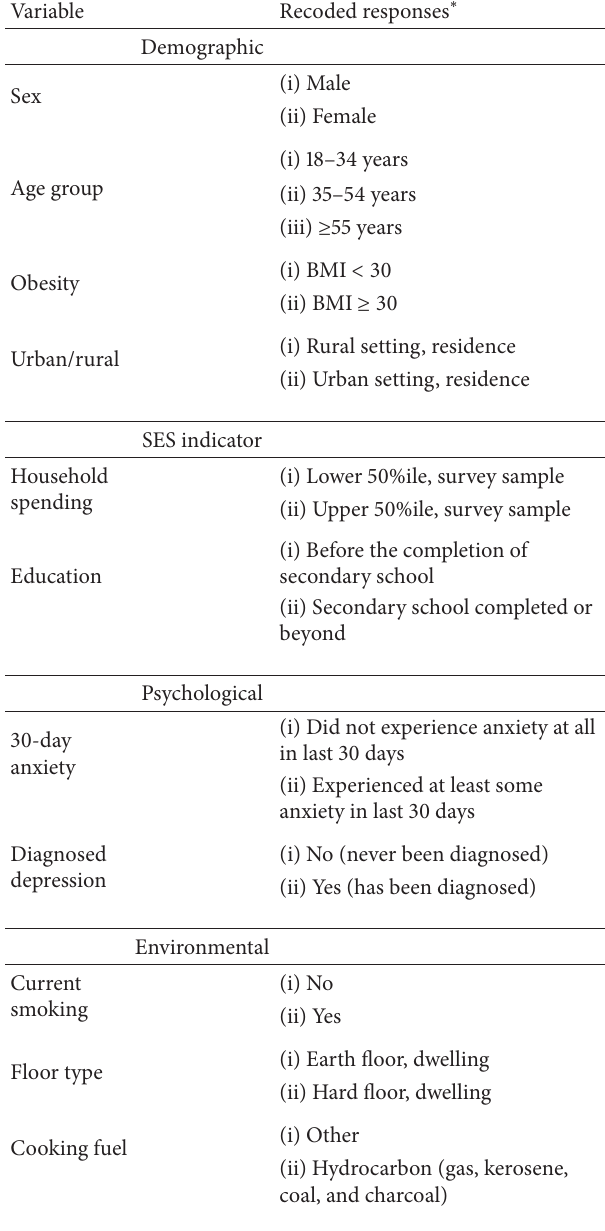
Table 3: Summary of independent